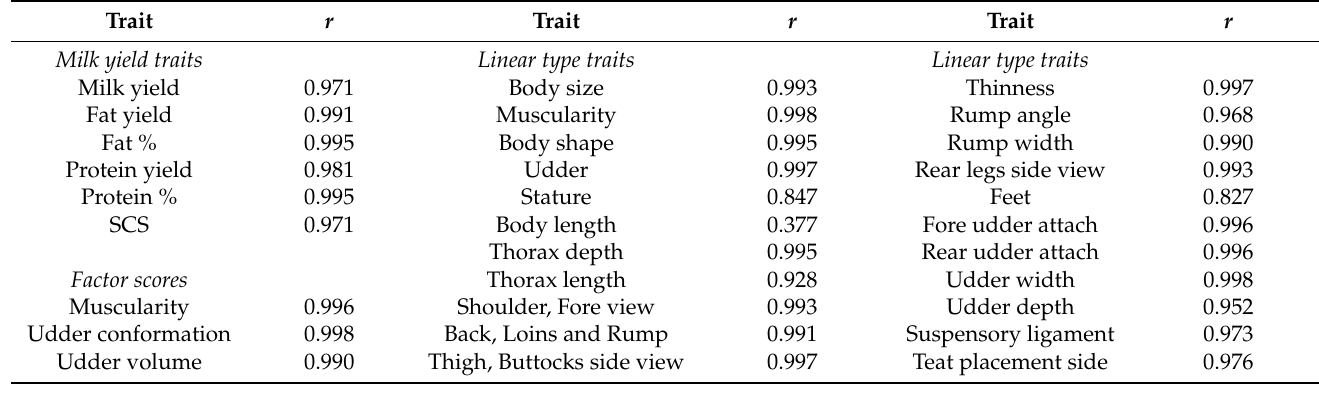
Table 3. Rank correlations ( r ) between EBVs of bulls obtained from the reaction norm model including GxE vs. the reaction norm model without GxE. All correlations have a statistical significance of p ≤ 0.001. Milk yield traits: n = 807; Linear type traits/Factor scores: n = 863. Traits are grouped in: Milk yield traits; Factor scores; Linear type traits (in italic).